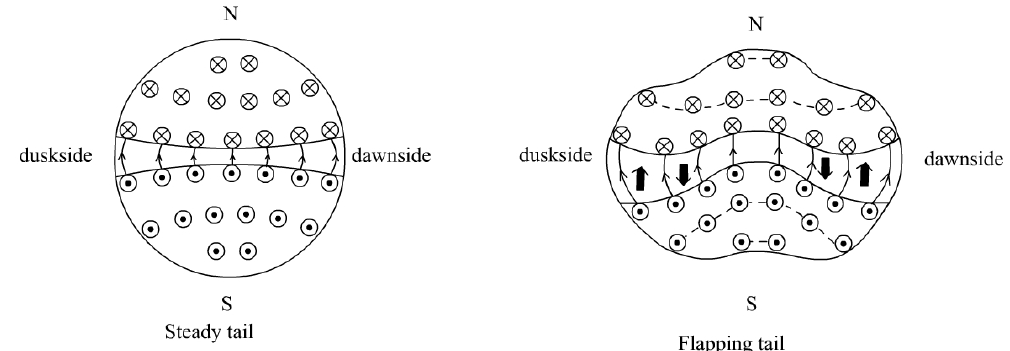
Fig. 11. Demonstration of the flapping motion of the near earth tail caused by the impact of disturbed solar wind. Table 3. Parameters of tail CS flapping